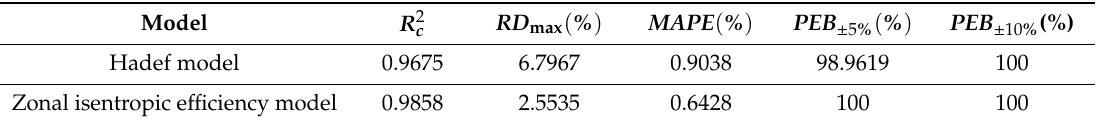
Table 2. Error evaluation criteria result for Hadef model and zonal compressor isentropic e ffi ciency model.